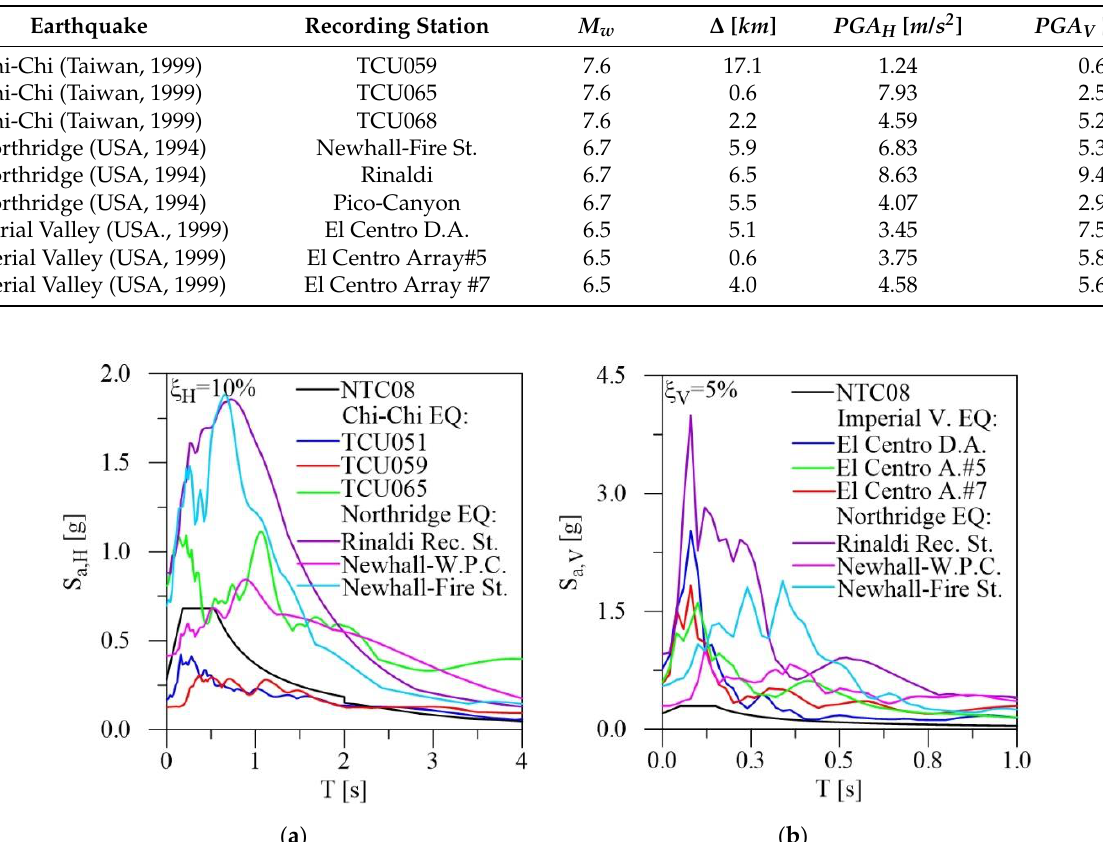
Table 8. Main features of the selected near-fault EQs (PEER database) [37].